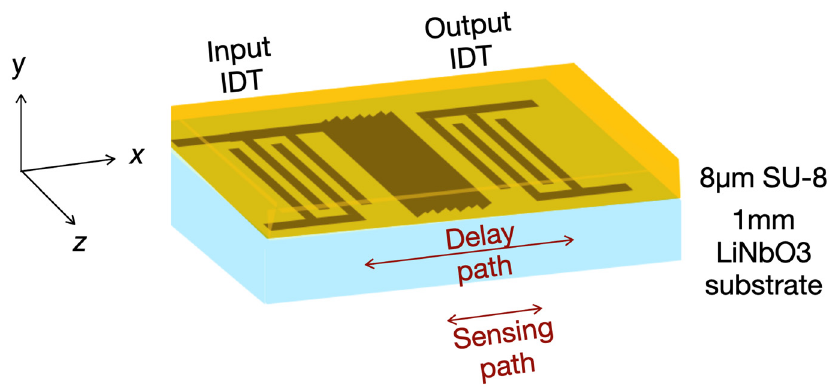
Figure 2. Schematic of a Love wave sensor. Love wave modes propagate from an input IDT to an output IDT. The L-SAW sensor has an 8-µm SU-8 guiding layer.